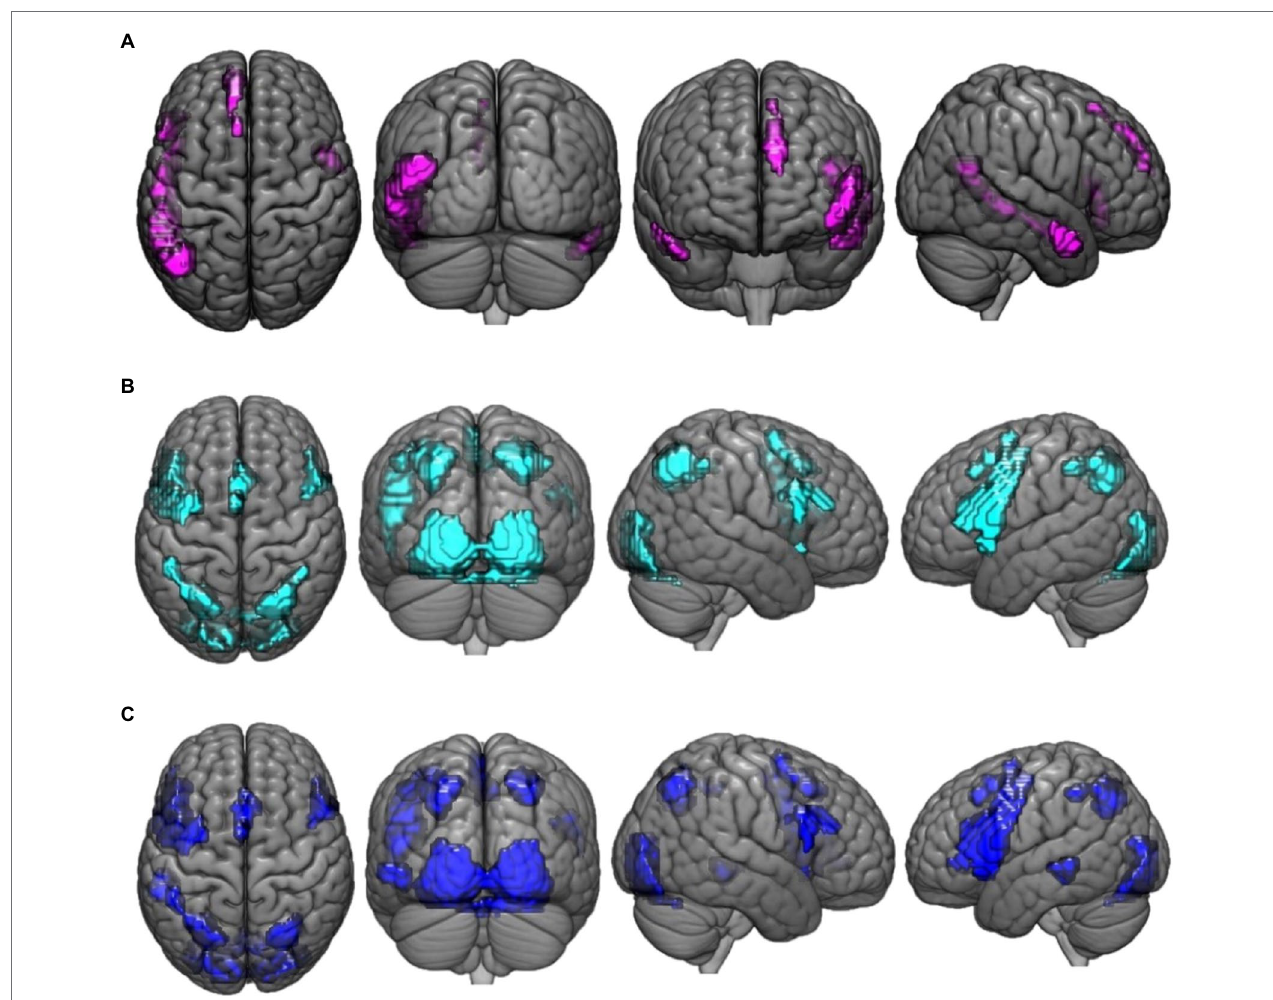
FIGURE 1 | This figure presents the neuroimaging results of the comparison of reasoning trials to the control task: (A) activation maps of areas that were significantly more activated during paradoxical reasoning compared to the control task; (B) activation maps of areas that were significantly more activated during deductive reasoning for valid syllogisms compared to the control task; and (C) activation maps of areas that were significantly more activated during deductive reasoning for invalid syllogisms compared to the control